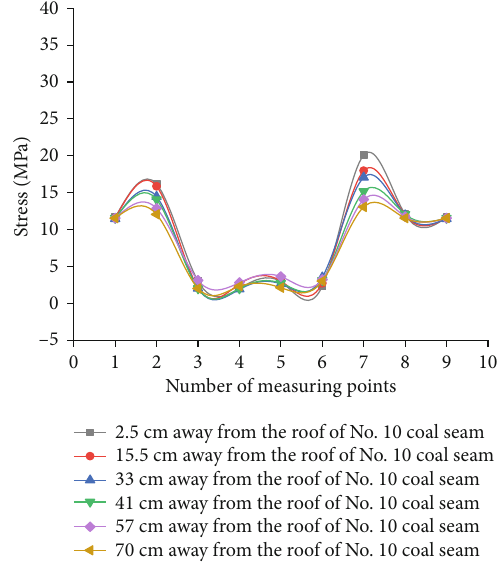
Figure 7: Stress diagram of working face mining at 150 m.